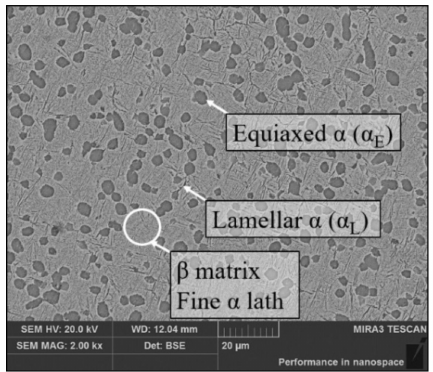
Figure 1. The initial microstructure of the Ti-55511 alloy. The volume fractions of the equiaxed α phase ( α E ), α L and β phase were counted as 25.44%, 14.47% and 60.9%, respectively, by Image-Pro Plus 6.0 software. The average diameter of the α E phase was 3.1 µ m and the average thickness of the α L phases was 0.245 µ m. In addition, many fine lamellar α phases were dispersed in the β matrix.